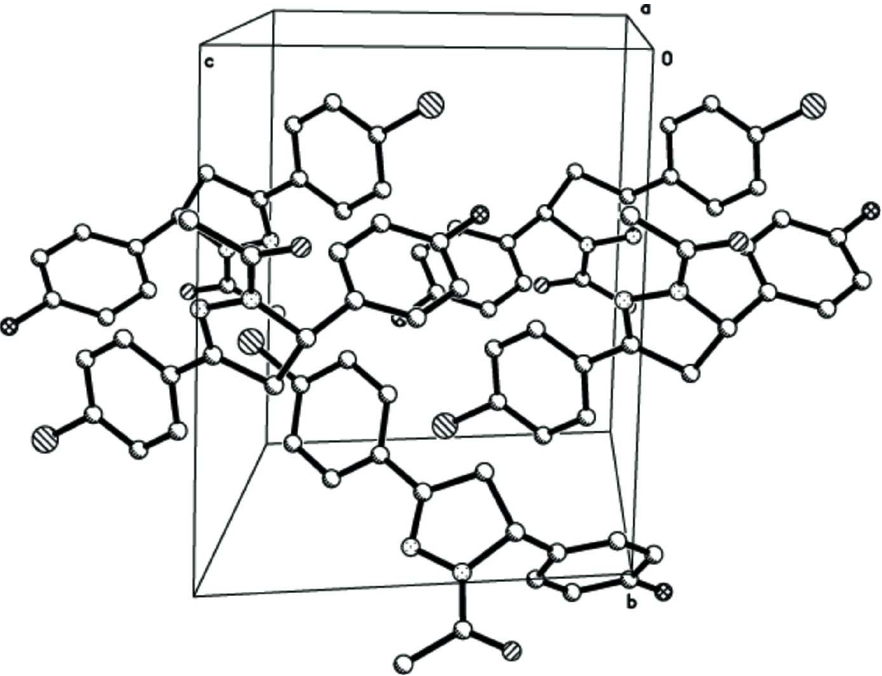
Figure 1 The molecular structure and atom-labeling scheme for (I), with displacement ellipsoids drawn at the 30% probability